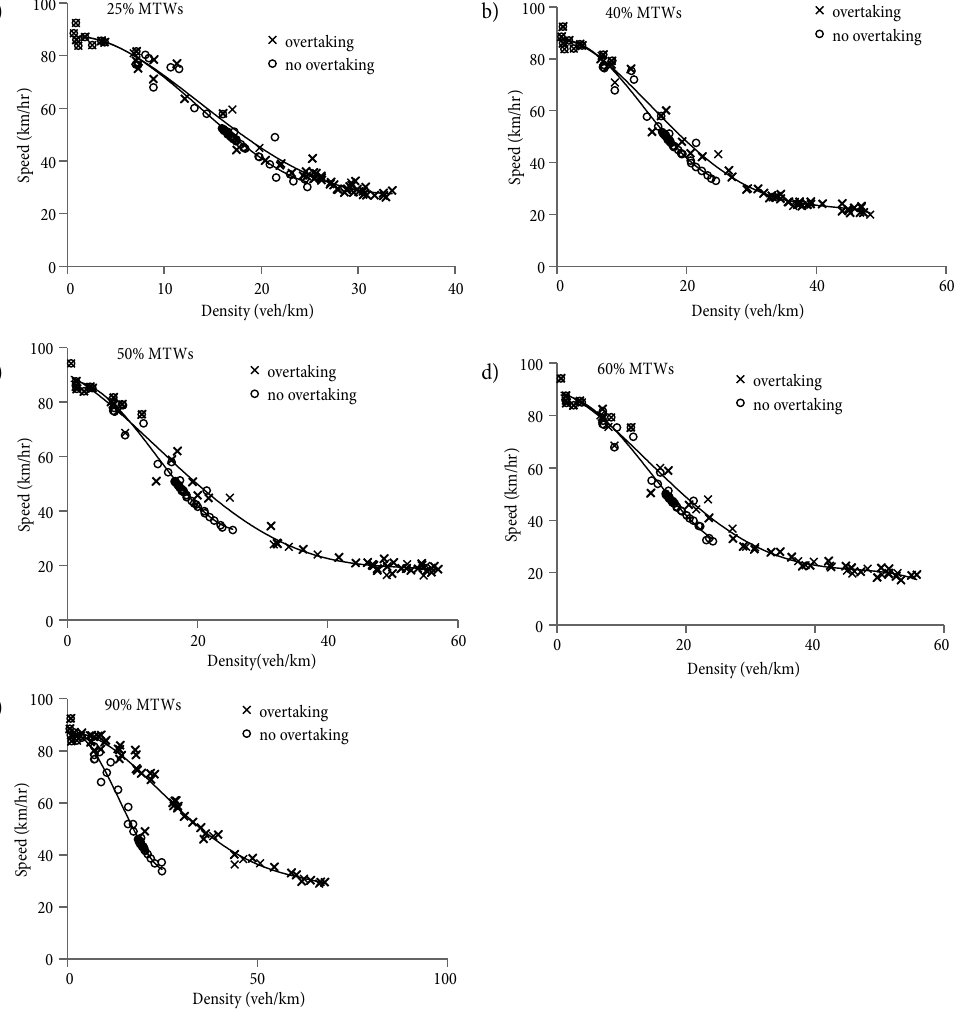
Fig. 6. Flow-density curves at: a – 25% MTW, rest all being cars; b – 40% MTW, rest all being cars;